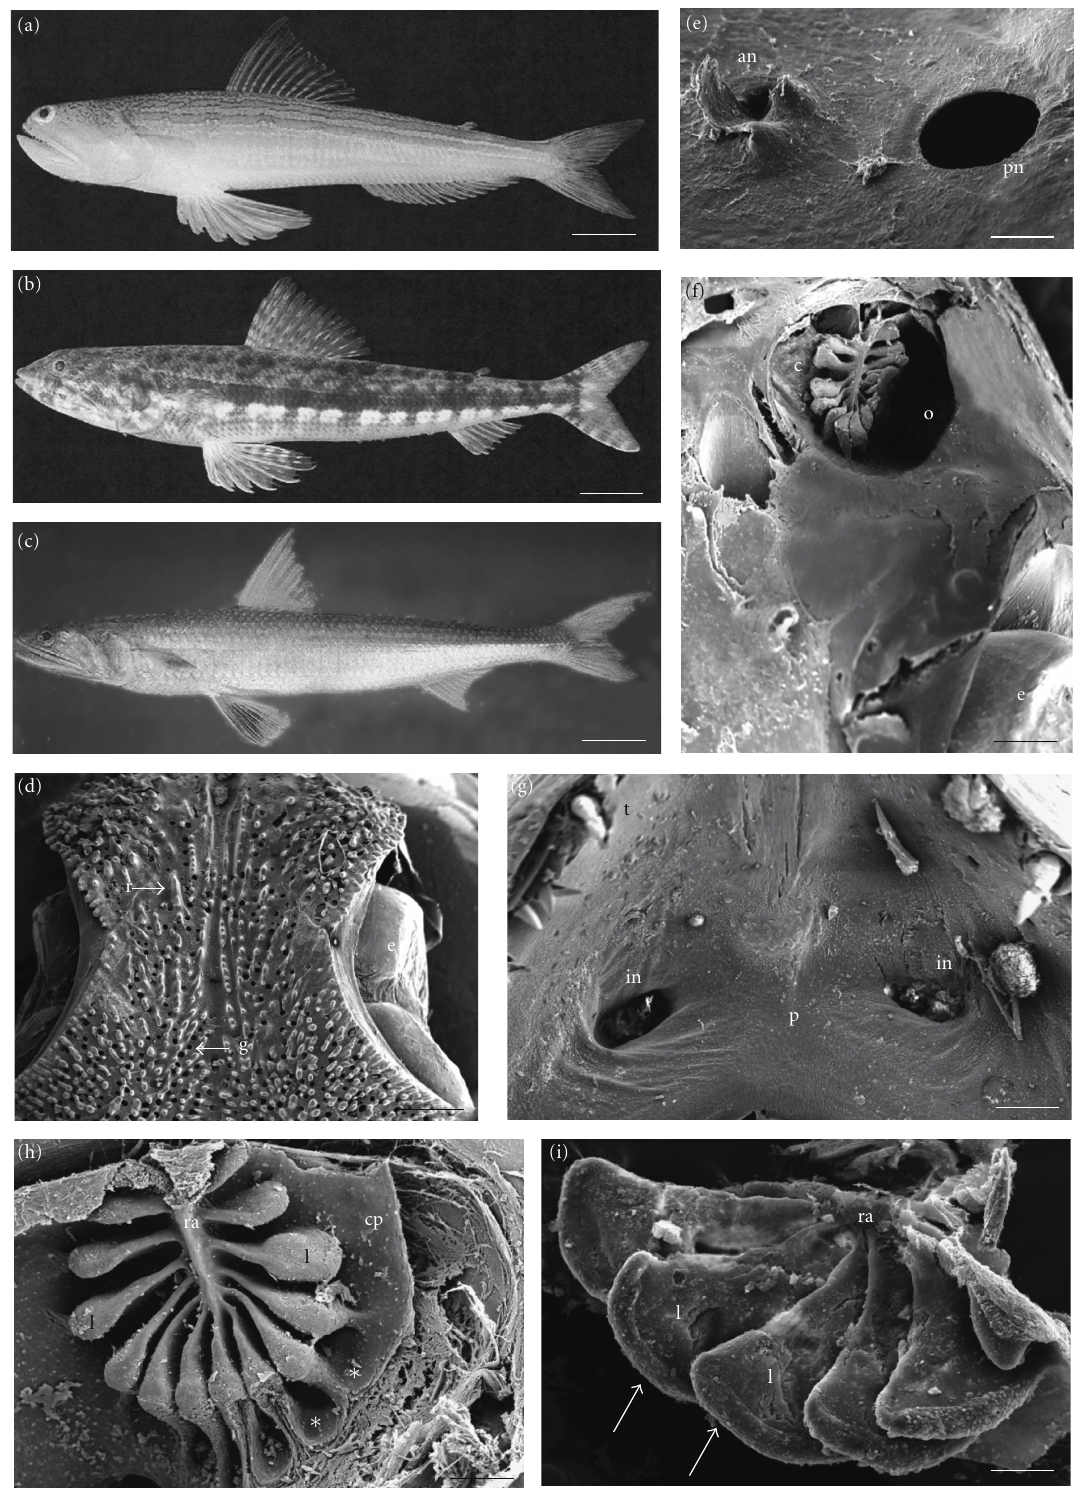
Figure 1: The genera of the studied lizardfishes, the olfactory nares, and olfactory rosettes. (a) Trachinicephalus myops ; (b) Synodus variegatus ; (c) Saurida tumbil , scale bar = 1.5cm; (d) dorsal skull surface of Trachinocephalus myops , scale bar = 4cm; (e) external nares of Sy. variegatus, scale bar = 0.8 mm; (f) open nasal capsule of Sy. saurus , scale bar = 3mm; (g) internal nares of Sy. variegatus , scale bar = 1.5mm; (h) olfactory rosette of Sy. kaianus , scale bar = 4mm; (i) One site of the olfactory rosette of T. myops , scale bar = 0.8 mm: an, anterior nare; c, olfactory capsule with rosette; cp, inner cover of olfactory capsule; e, eye; g, lines of mucus gland cells; in, inner nares; l, olfactory lamellae; o, deeper part of the olfactory capsule; p, anterior part of the palate; pn, posterior nare; r, ridges on the head; ra, raphe of rosette; t, teeth of upper jaw; star, passages for water transport; arrows, swollen margins of olfactory